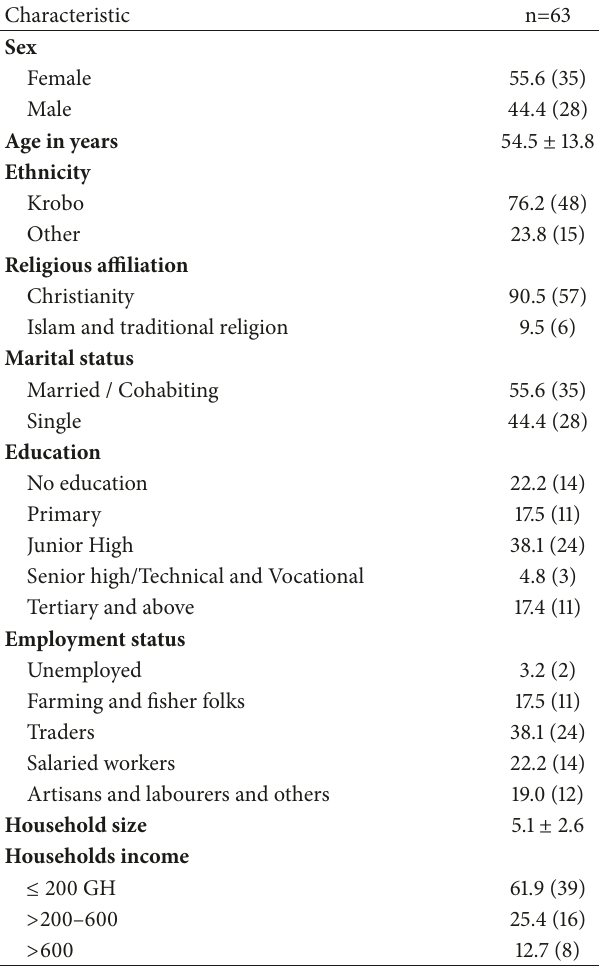
Table 1: Selected background sociodemographic characteristics of study